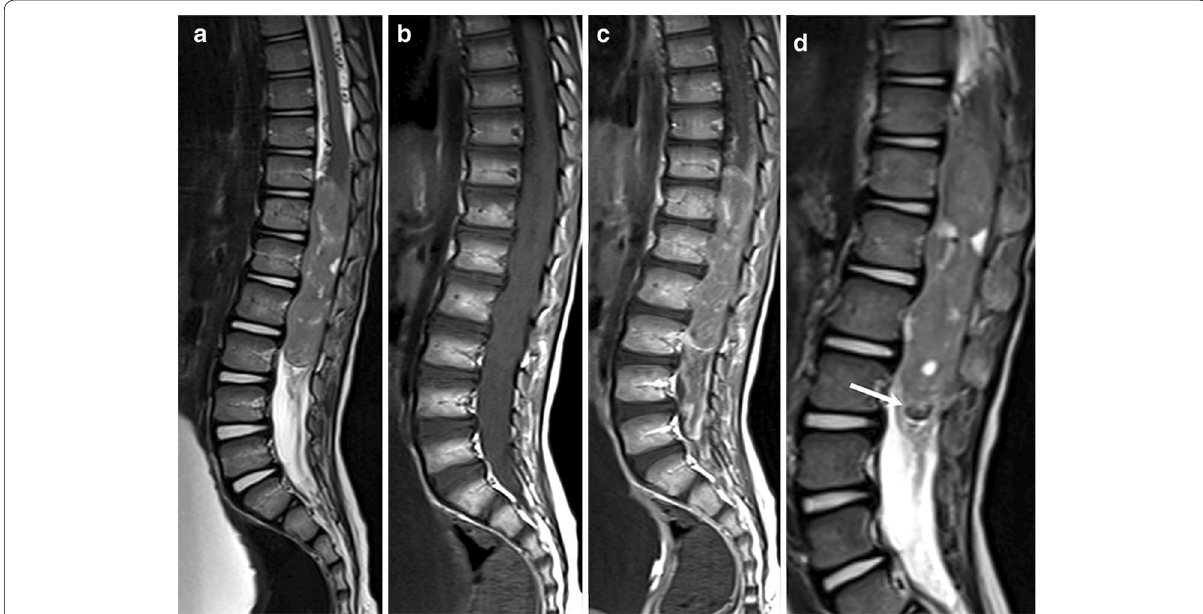
Fig. 1 Magnetic resonance imaging (MRI) of a 4‑year‑old boy with spinal glioblastoma multiforme (GBM) of the conus medullaris at the time of diagnosis. MRI shows a large heterogeneous mass extensively filling the spinal canal between T11 and L3. The lesion shows hyperintense and inho‑ mogeneous signal intensity on Sagittal T2‑weighted images ( a ) and isointense signal intensity on Sagittal T1‑weighted images ( b ). After gadolinium (Gd) injection, a diffuse, inhomogeneous enhancement of the tumor is observed, and the tecal sac is filled by abundant enhancing tissue envelop‑ ing the conus medullaris and cauda equina ( c ). The regions of hypointensity within the tumor and along the inferior margin of the lesion shown on sagittal T2‑weighted images suggest tumoral bleeding ( arrow ) ( d